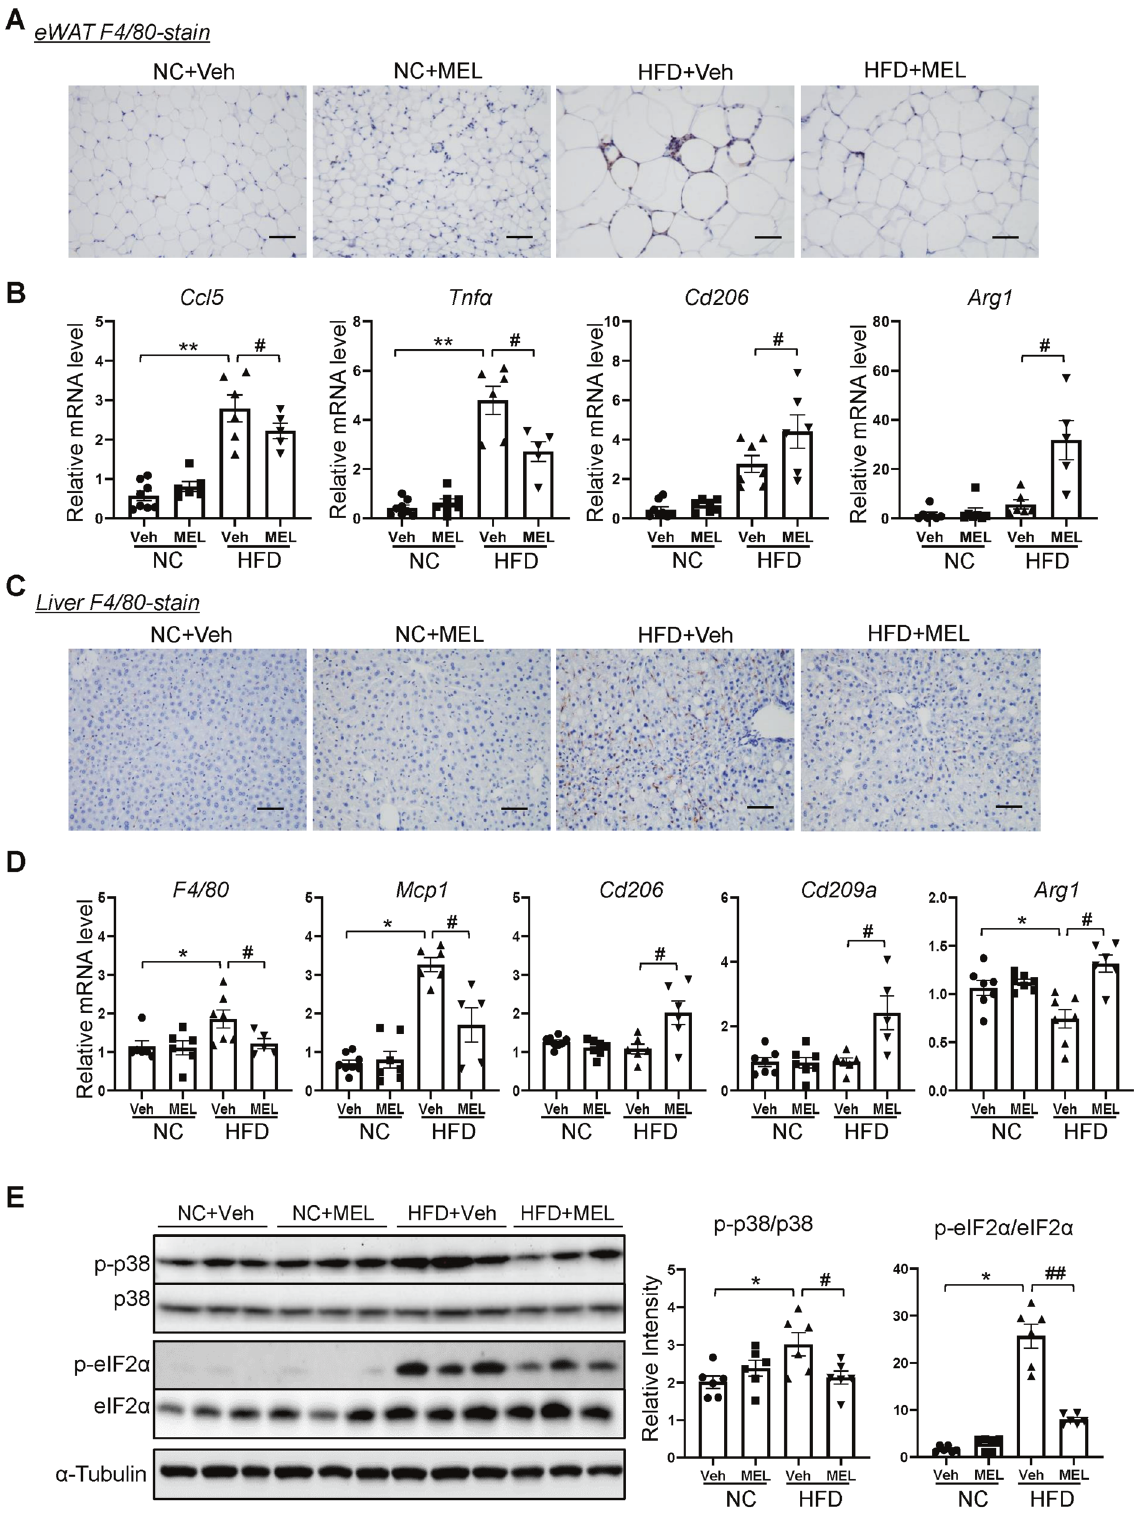
Fig. 7 Melatonin attenuates adipose tissue and liver in fl ammation in HFD-fed mice. A F4/80 immunostaining of eWAT. Scale bars = 100 μ m. B Levels of pro- and anti-in fl ammatory cytokine mRNAs in eWAT. C F4/80 immunostaining of the liver. Scale bars = 100 μ m. D Levels of F4/80, and pro- and anti-in fl ammatory cytokine mRNAs, in the liver. E Immunoblots of phosphorylated p38 MAPK and eIF2 α , and their total protein contents in the liver. Data are mean ± SEM, n = 5 – 8. Signi fi cance was determined by one-way ANOVA. *p < 0.05, **p < 0.01 vs. NC + Veh mice; # p < 0.05, ## p < 0.01, vs. HFD + Veh